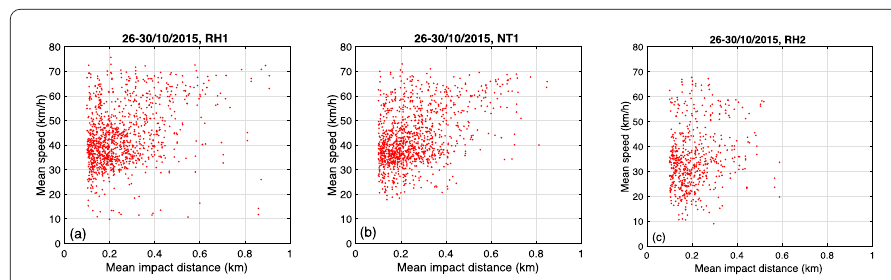
Figure 11 Mean road speed over the considered time period VS mean impact distance. ( a ) During RH1 ( b ) During NT1. ( c ) During RH2. The data is during 26–30 Oct. 2015, N = 4530, L = 900, and τ max = 150. Pearson’s correlation: ( a ) 0.3187, ( b ) 0.4103, ( c ) 0.1957